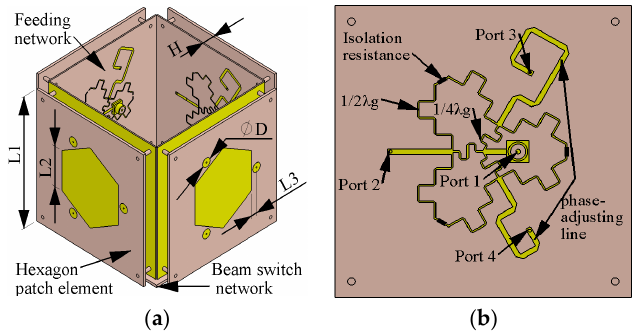
Figure 3. ( a ) Structure of the proposed BSBCPA. ( b ) Structure of the feeding network ( λ g is the wavelength in the substrate of the feeding network). wavelength in the substrate of the feeding network).